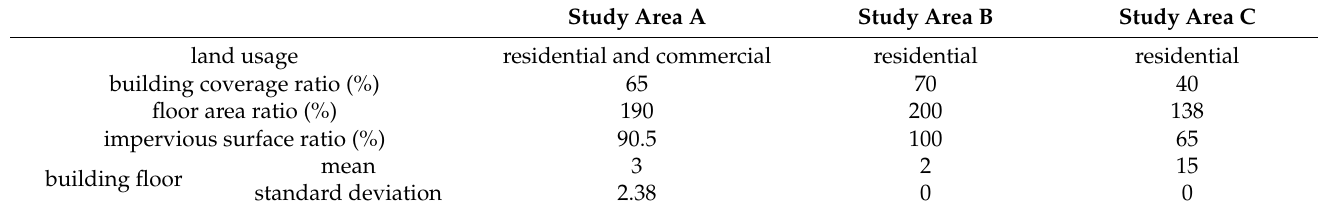
Table 2. Urban spatial characteristics for study areas A, B and C.